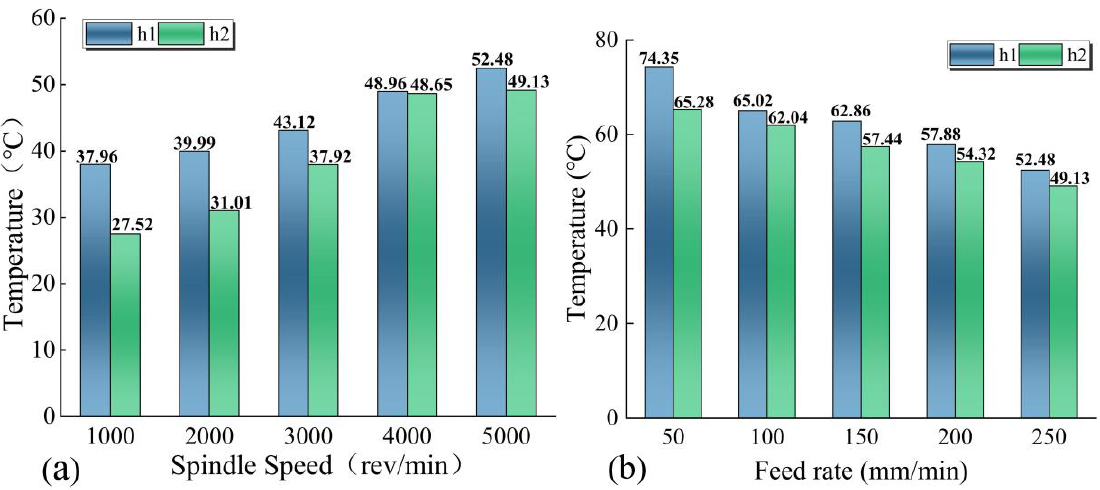
Figure 8. Comparative graphs of the temperatures of h1 and h2. ( a ) Spindle speed of 5000 rev/min; ( b ) Feed rate of 50 mm/min.